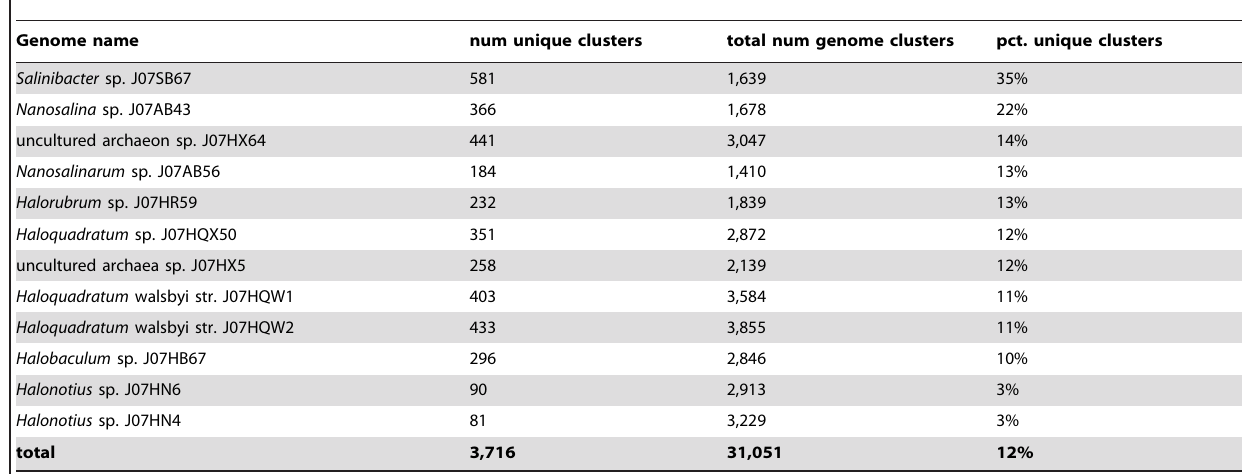
Table 2. Population-unique protein family